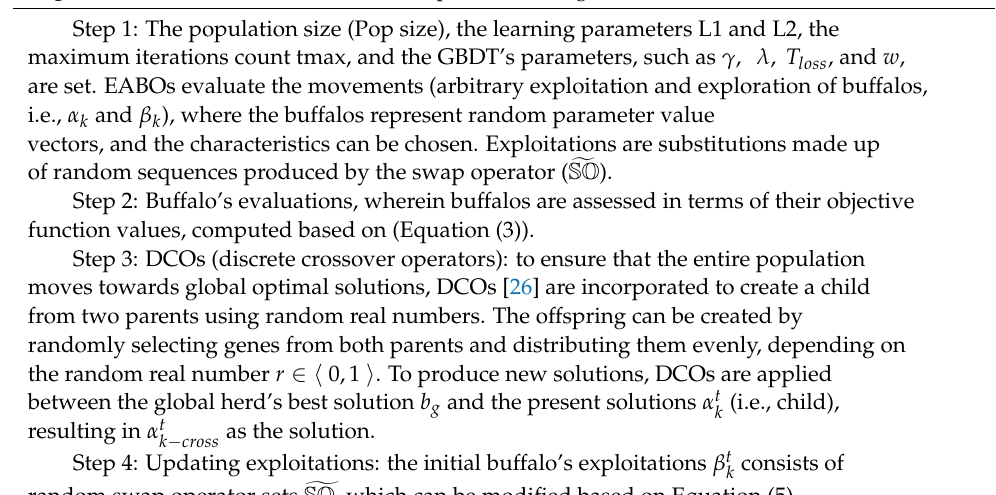
Algorithm 1: Enhanced African buffalo optimization